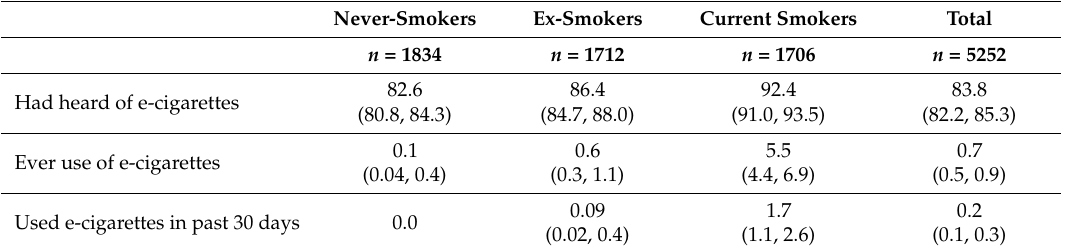
Table 2. Prevalence of being aware of e-cigarettes, and use of e-cigarettes in all respondents, weighted % (95% Confidence Interval